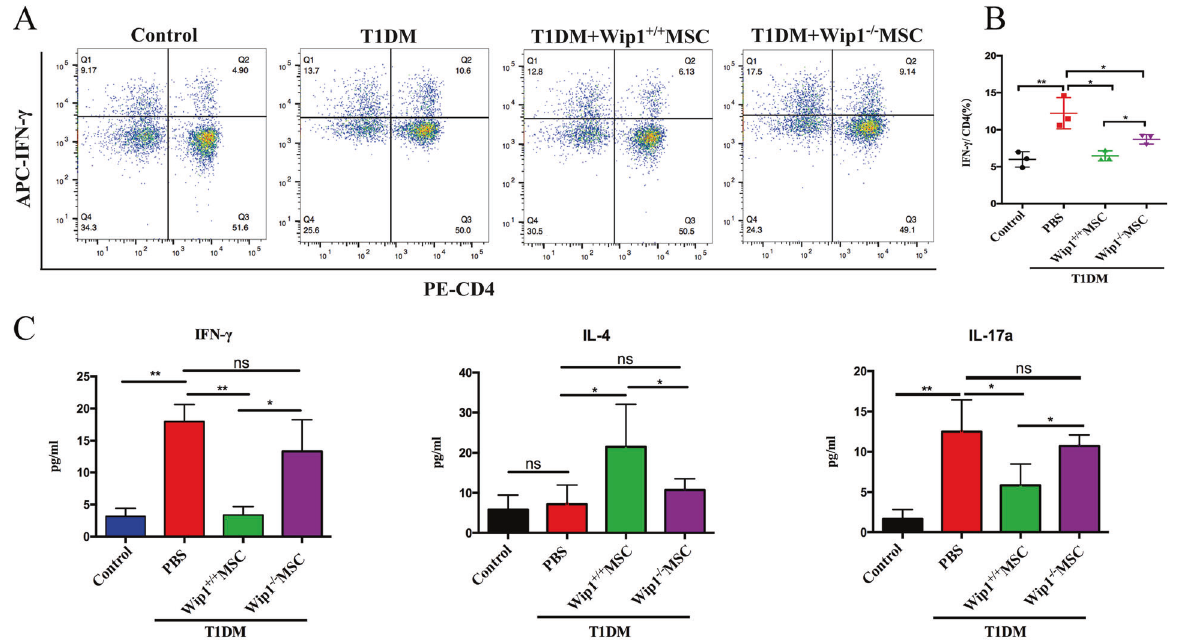
Fig. 3 Wip1 − / − MSCs exhibited lower immunosuppression response in T1DM mice. A Frequency of CD4 + IFN- γ + Th1 cells was analyzed by fl ow cytometry in MSCs-treated T1DM mice. B The quantitative results for CD4 + IFN- γ + Th1 cells in splenic lymphocytes. C Serum IFN- γ , IL-17a, and IL-4 were detected by ELISA. ( n = 7, three independent experiments) ns, not signi fi cant, * P < 0.05, ** P <